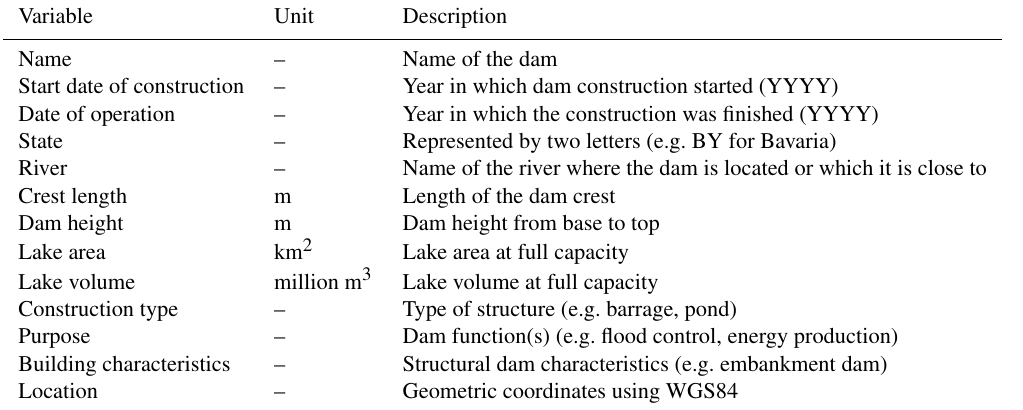
Table 2. Data present in the dam inventory with